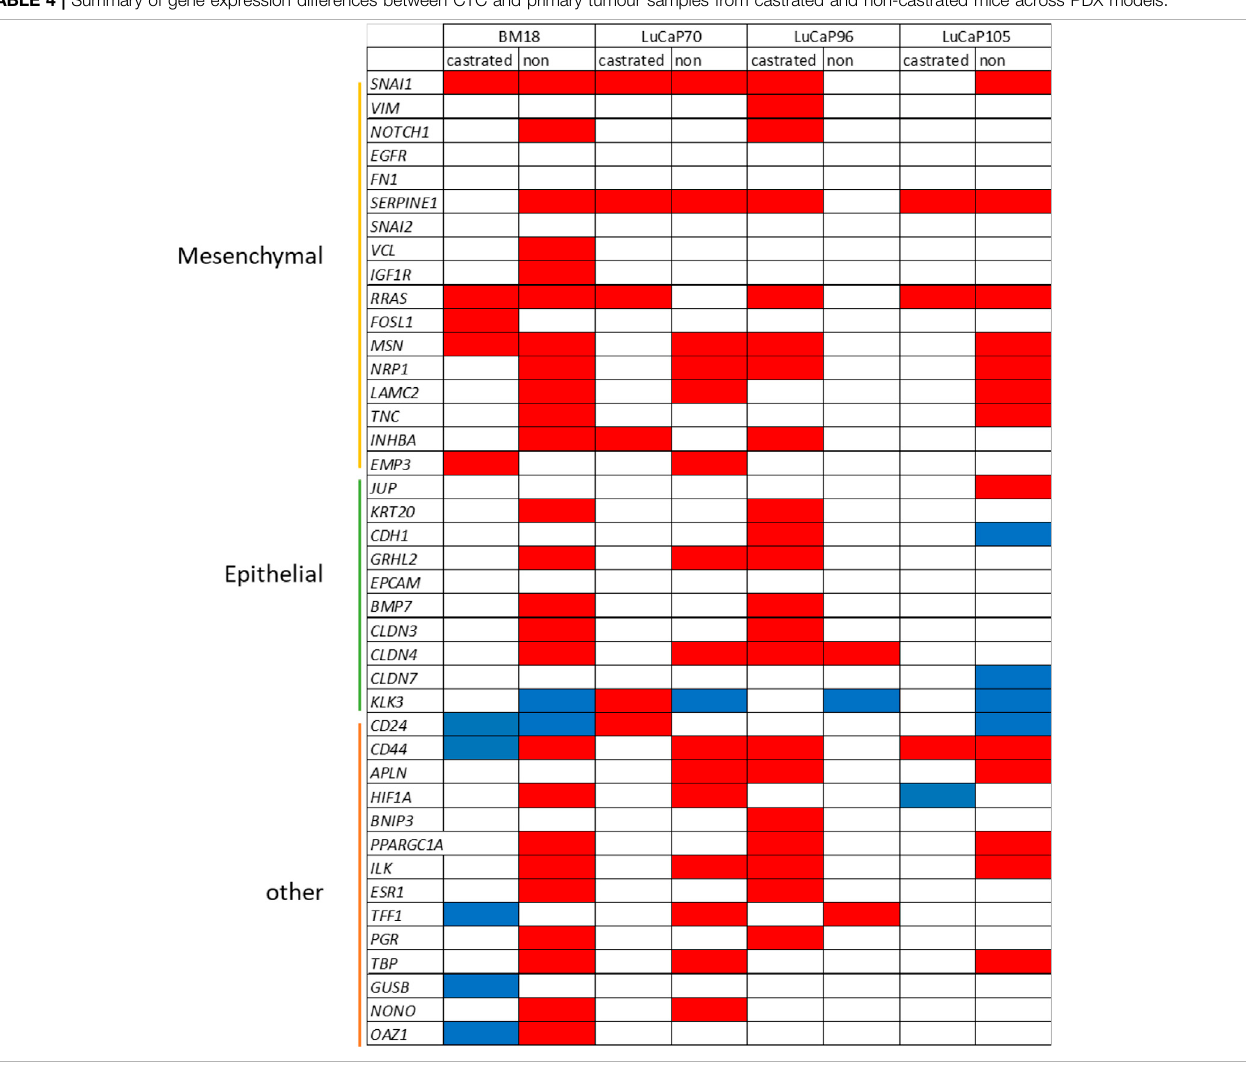
Frontiers in Cell and Developmental Biology |